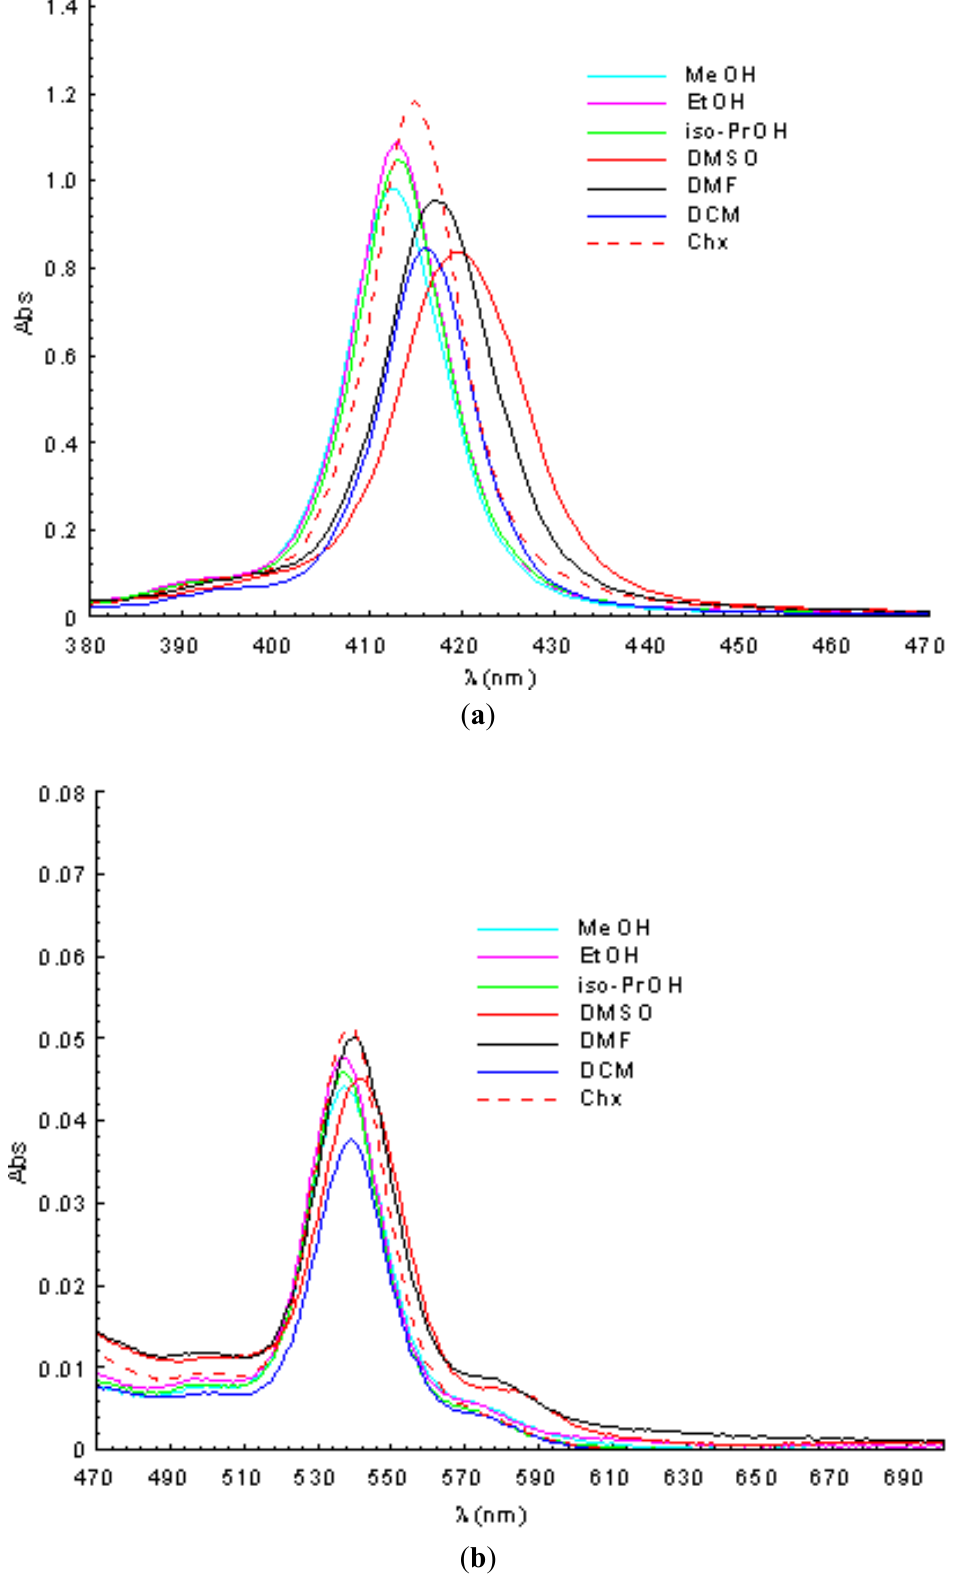
Figure 2. Absorption spectra of Cu(II)-5,10,15,20- meso